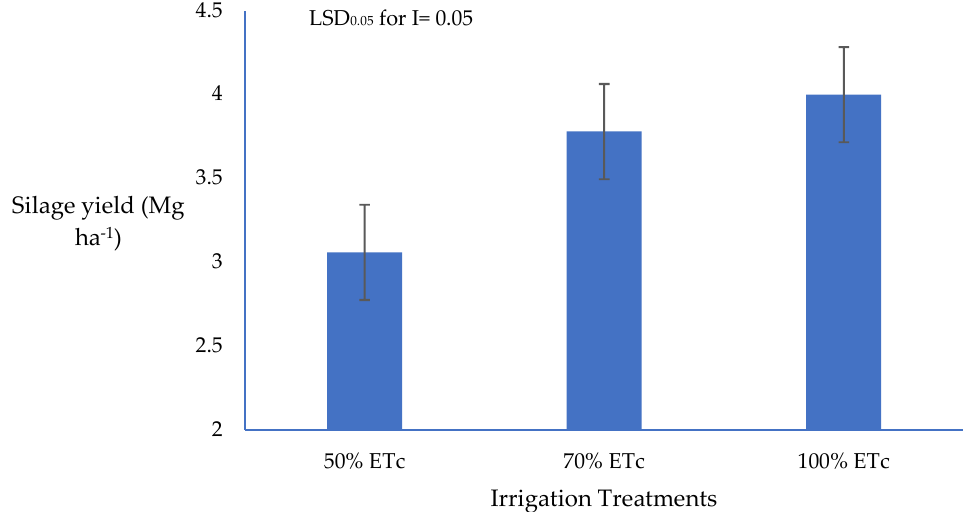
Figure 3. Silage yield during the two years, 2019 and 2020. Data presented are mean values, where LSD 0.05 is the Least Significant Difference at the 0.05 significance level. Notes: 50% ET c : 50% of evapotranspiration; 70% ET c : 70% of evapotranspiration; 100% ET c : 100% of evapotranspiration (control). Error bars correspond to the Standard Errors of the mean values.